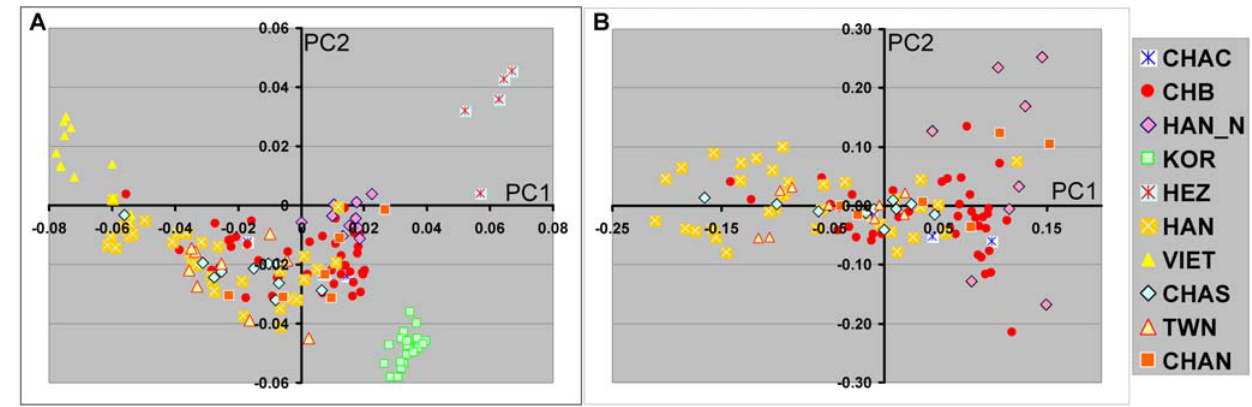
Figure 4. PCA analyses of Han Chinese and Chinese American population groups. A , Results from PCA performed together with EAS populations. B , PCA performed using only Chinese and Chinese American participants. The color coded population groups included the HapMap Han Chinese from Beijing (CHB), HGDP Han Chinese (HAN), HGDP North Han Chinese (HAN_N), Chinese American North (CHAN), Chinese American South (CHAS), Chinese American Central (CHAC), Taiwan Chinese American (TWN), Korean (KOR), and Hezhen (HEZ).